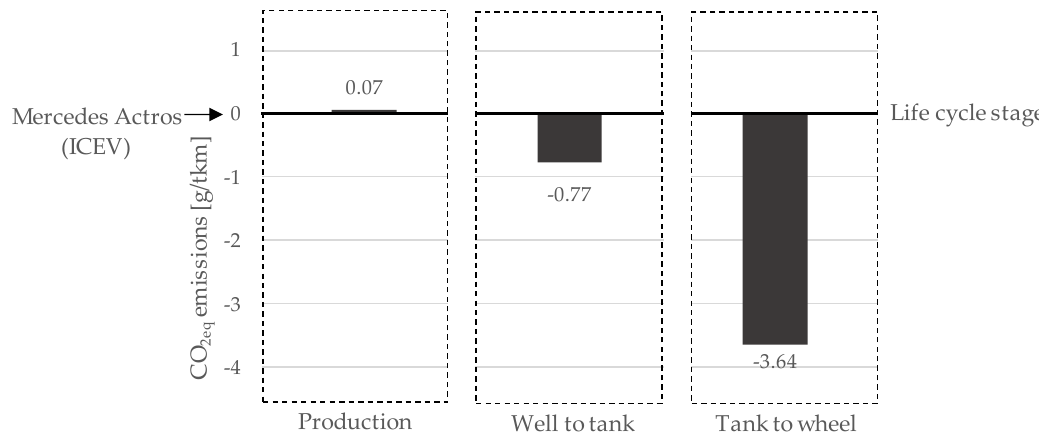
Figure 5. CO 2eq emission reduction potential of hybrid electric vehicle (HEV) compared to internal combustion engine vehicle (ICEV).